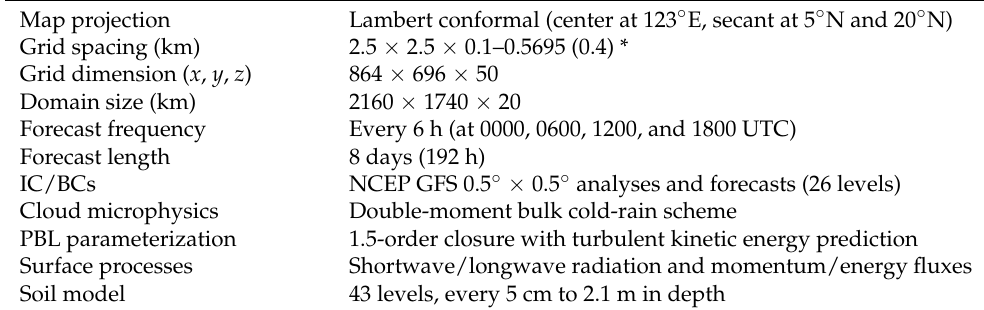
Table 1. Domain configuration and physical packages of the CReSS model in this study. Map